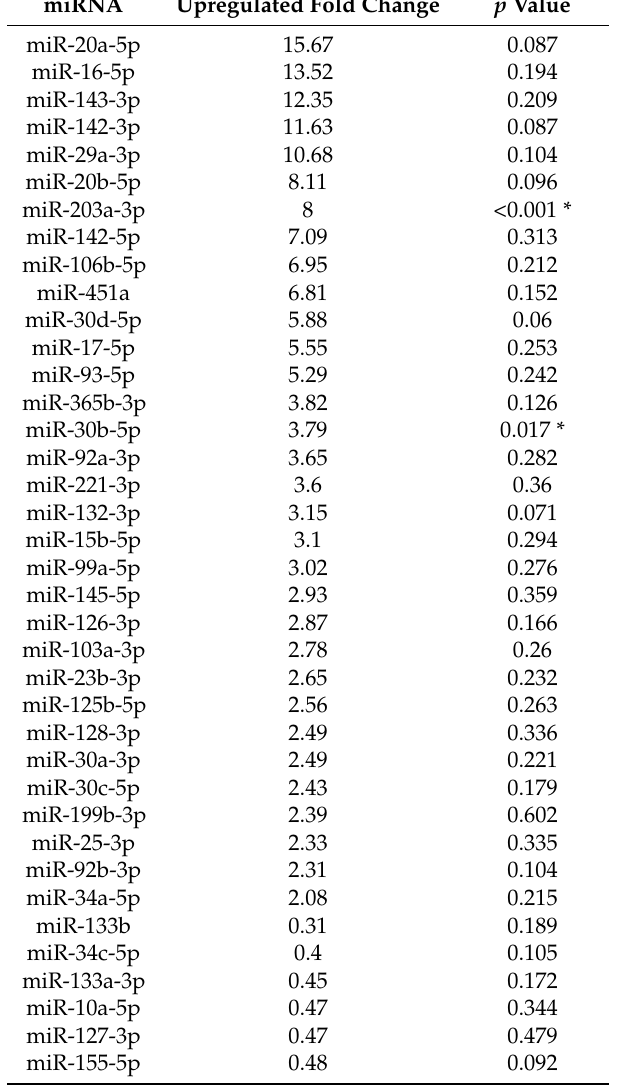
Table 2. The fold change (low-OHRQoL group/high-OHRQoL group) of miRNAs. miRNA